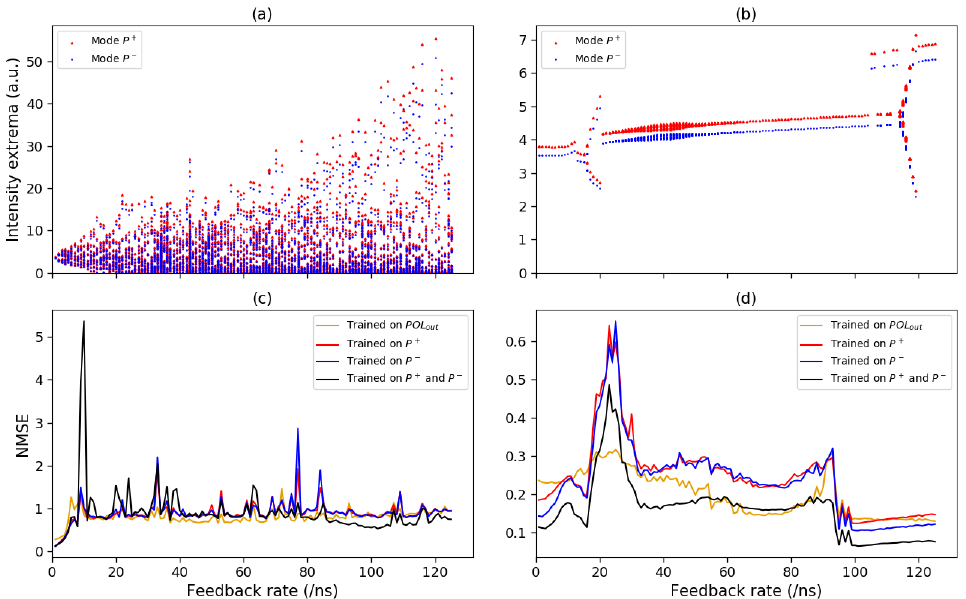
Figure 3. Orbit diagram of the modal output power as the feedback rate η is varied for ( a ) τ D = 150 ps and ( b ) τ D = 15 ps. The NMSE for the Santa Fe timeseries prediction task as the feedback is varied for ( c ) τ D = 150 ps and ( d ) τ D = 15